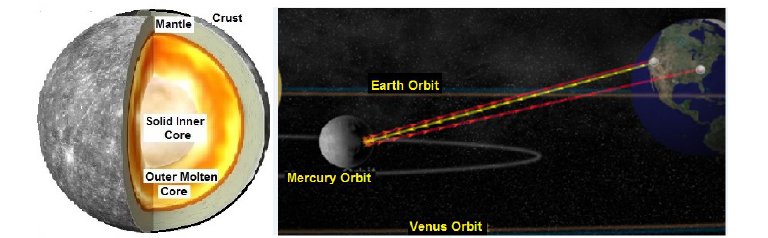
Fig. 9 . The internal structure of Mercury (left) obtained by